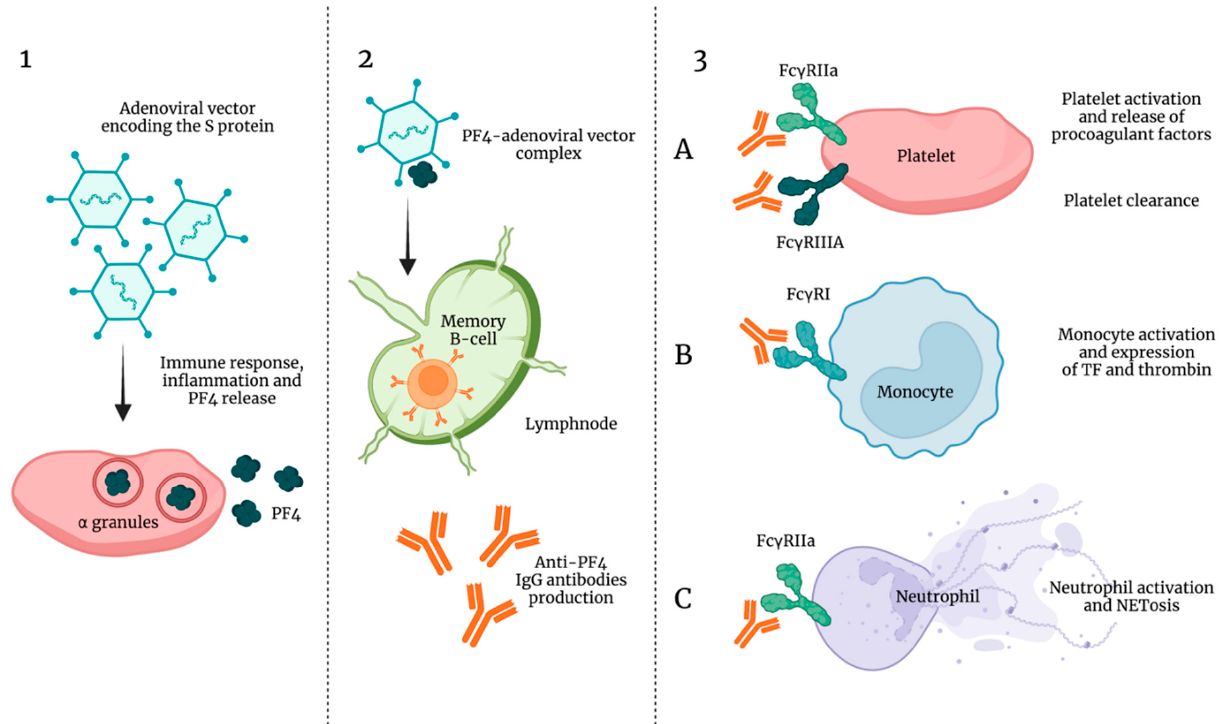
Figure 5. Pathogenesis of vaccine-induced thrombocytopenia and thrombosis (VITT). ( 1 ) Adenoviral vector encoding the S protein triggers an inflammatory response and platelet release of PF-4. ( 2 ) PF4–adenoviral vector complexes stimulate B-cells to produce anti-PF4 IgG antibodies (VITT antibodies). ( 3 ) ( A ) VITT antibodies bind Fc γ RIIa on the platelet surface causing platelet activation and release of procoagulant factors; VITT antibodies bind Fc γ RIIIA causing platelet clearance and thrombocytopenia. ( B ) VITT antibodies bind Fc γ RI on the monocyte surface causing monocyte activation and expression of TF and thrombin. ( C ) VITT antibodies bind Fc γ RIIa on the neutrophil surface causing neutrophil activation and NETosis.